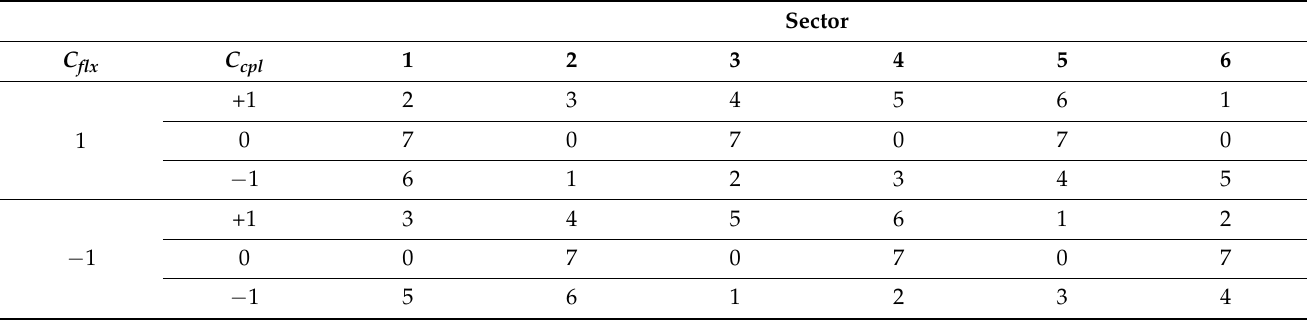
Table 1. Switching table of two-level inverter.